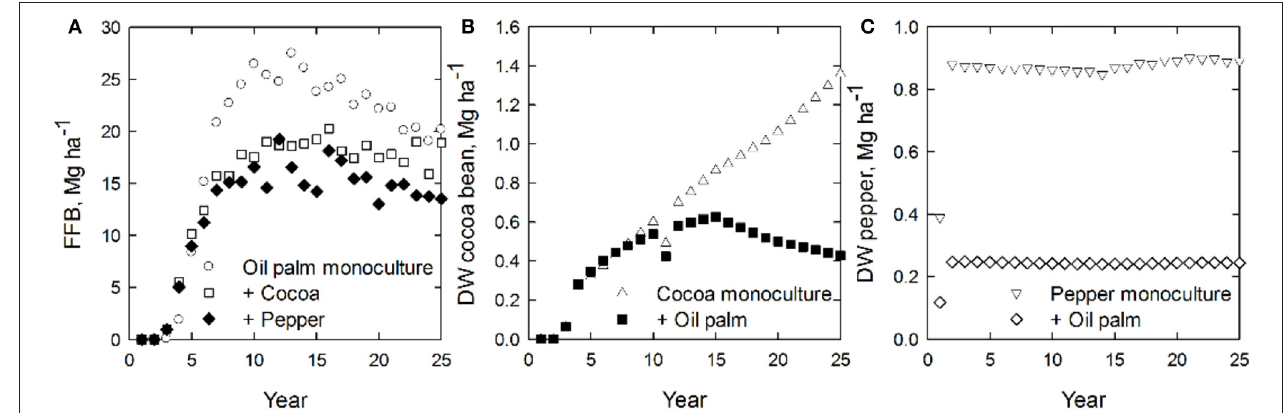
FIGURE 5 | Production of fresh fruit bunches (A) , dry weight of cocoa bean (B) , and dry weight of pepper (C) (Mg ha − 1 ) of different simulated systems.